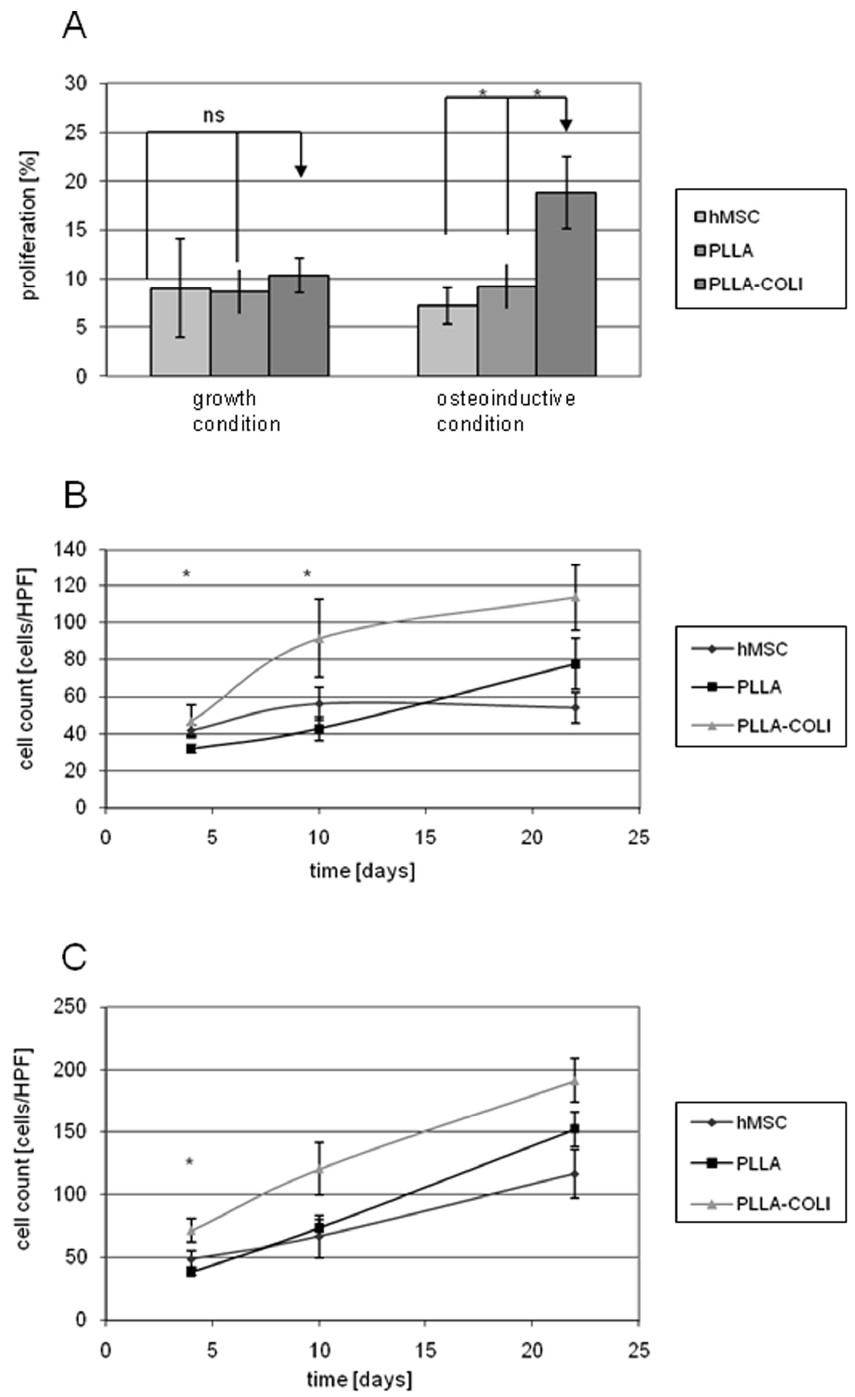
FIGURE 5 . Influence of PLLA-COLI (4:1) blend on growth and proliferation. Proliferation of hMSC cultured under both growth and osteoinductive conditions at day 4 (A). Time course of cell densities cultured under growth (B) as well as osteoinductive conditions (C). (hMSC – control group hMSC cultured on cover